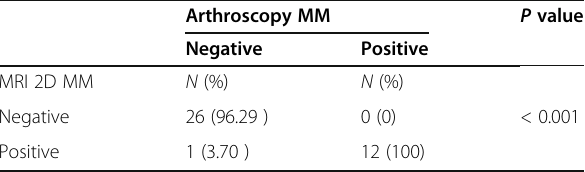
Table 3 Arthroscopic findings correlated with MRI protocol A for MM lesions